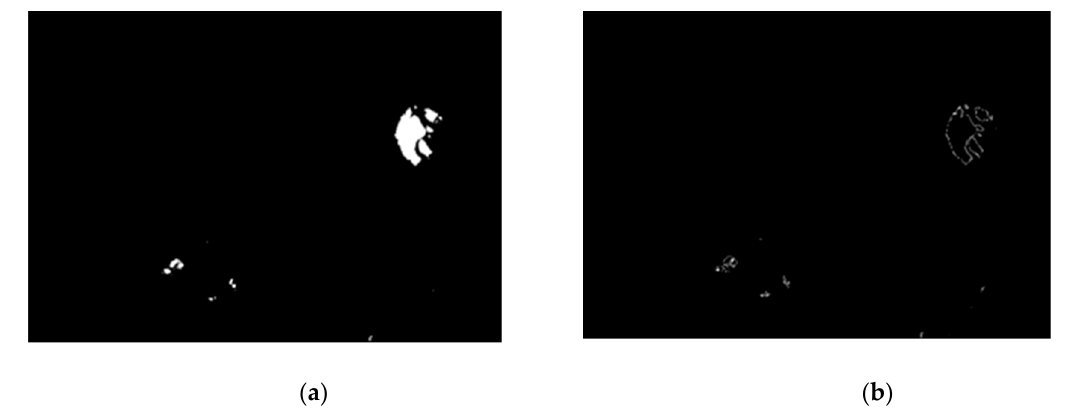
Figure 16. Image ( a ) after binarization and ( b ) calculated image variance.